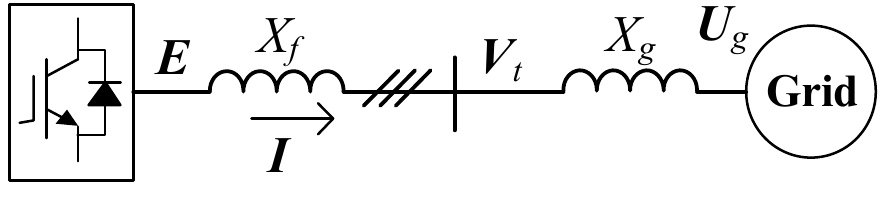
Figure 8. Simplified network topology.